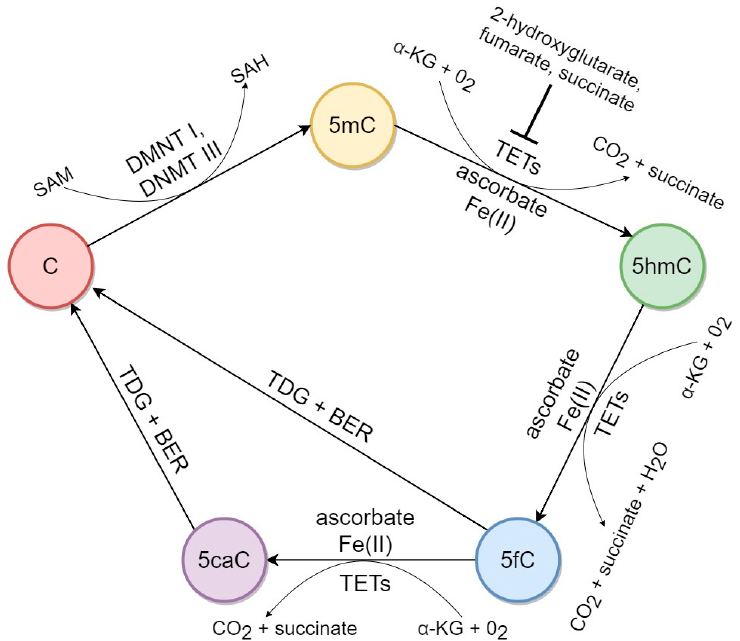
Figure 1. 5-hydroxymethylcytosine (5hmC) biochemical pathways in mammalian DNA. 5hmC is produced by TET protein-mediated oxidation (hydroxylation) of 5-methylcytosine (5mC). TET proteins utilize alpha-ketoglutarate ( α -KG) and oxygen (O 2 ) as co-substrates and require co-factors Fe(II) and ascorbate to yield 5hmC, CO 2 , and succinate. Succinate, fumarate, and 2-hydroxyglutarate are inhibitors of TET activity. Further TET-driven oxidation of 5hmC consistently produces 5- formylcytosine (5fC) and 5-carboxylcytosine (5caC), which are replaced with cytosine (C) by thymine- DNA glycosylase (TDG)-mediated base excision repair (BER). DNA methyltransferases I and III (DNMTs I and III) transfer methyl group from S-adenosylmethionine (SAM) to cytosine producing 5mC and S-adenosylhomocysteine (SAH).